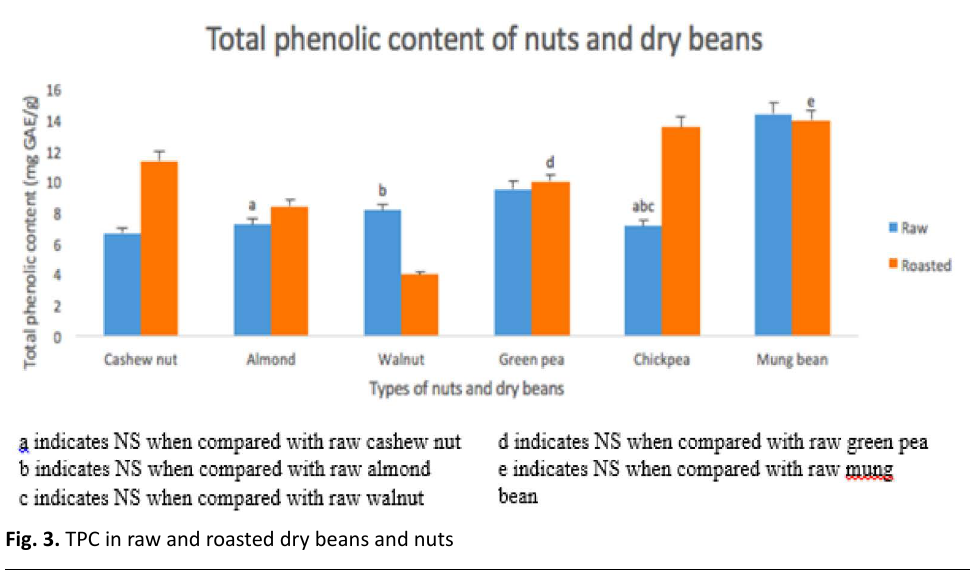
Fig. 3. TPC in raw and roasted dry beans and